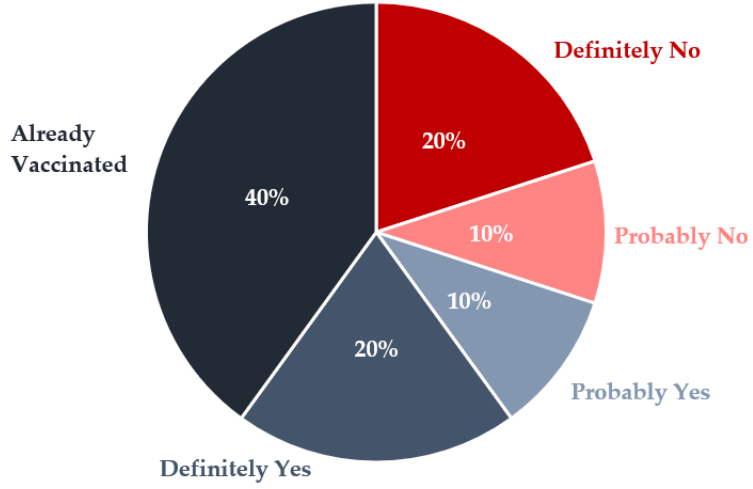
Figure 1. Likelihood of COVID-19 Vaccination among GPD Veterans.